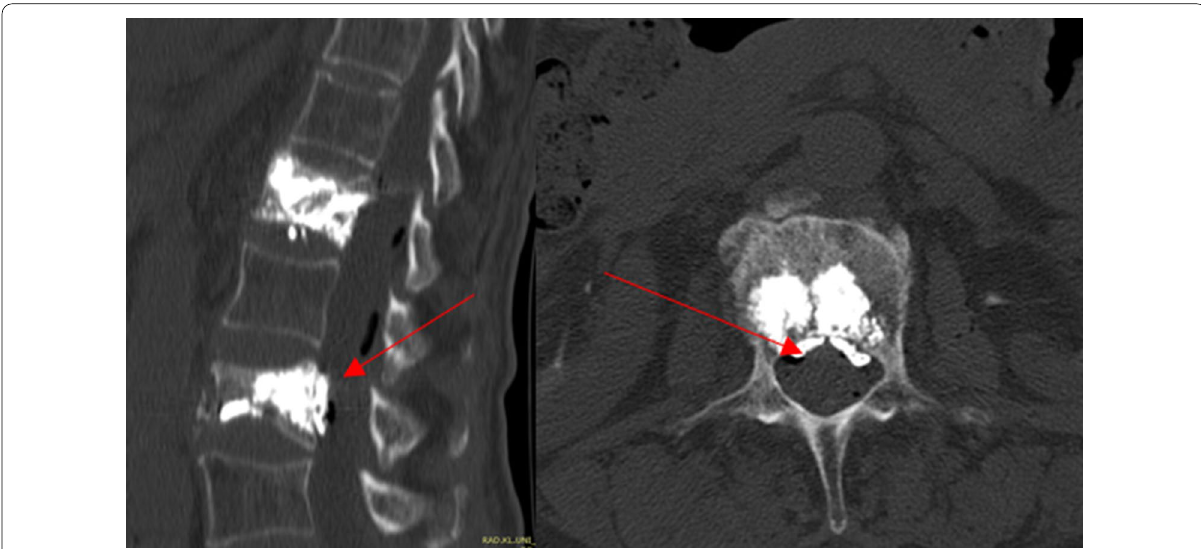
Fig. 2 Postoperative CT scan showing complications consisting of cement extravasation (intraspinal) without neurological